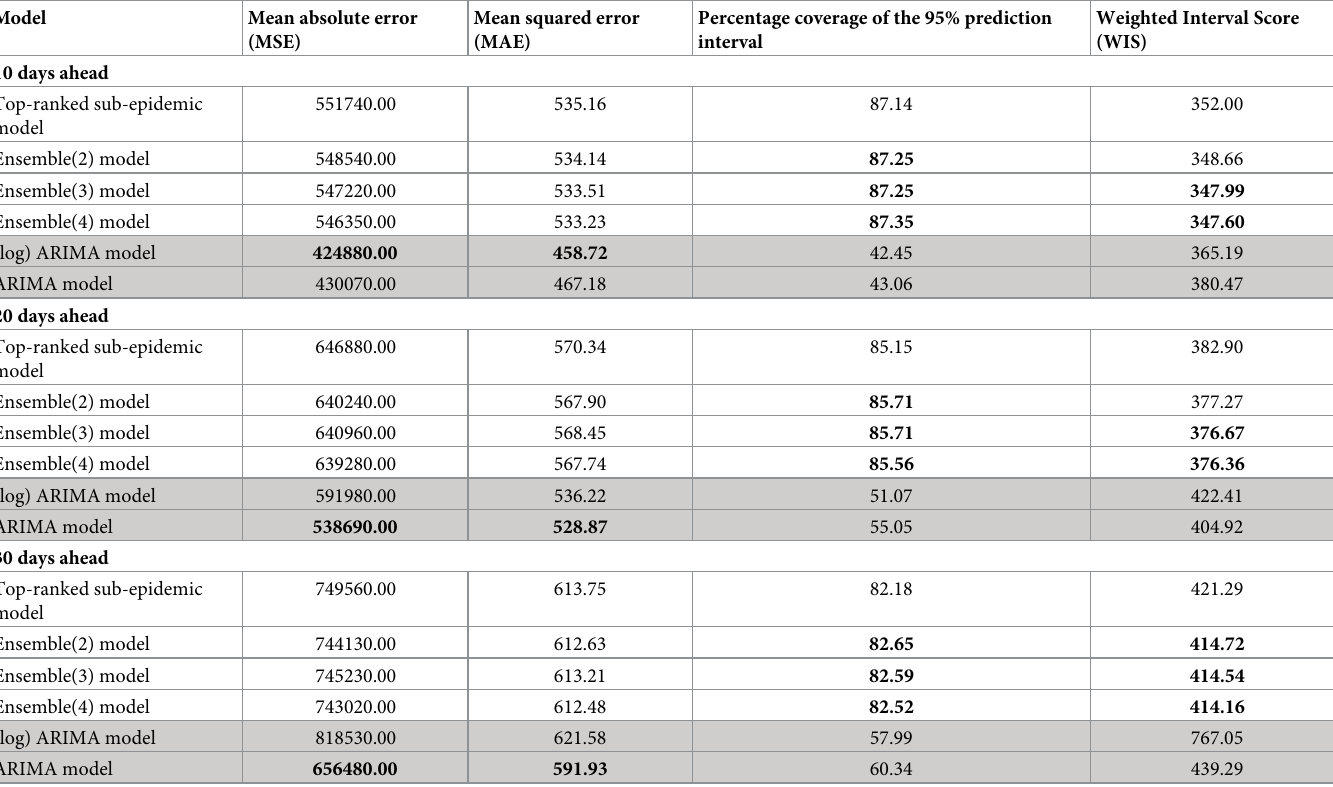
Table 3. Mean forecasting performance metrics for the sub-epidemic models (ensemble weights were based on the relative likelihood) and the ARIMA models across 98 sequential weekly calibration periods of the daily time series of COVID-19 deaths in the USA from 20-April-2020 through 22-February 2022. Values highlighted in bold correspond to the best performance